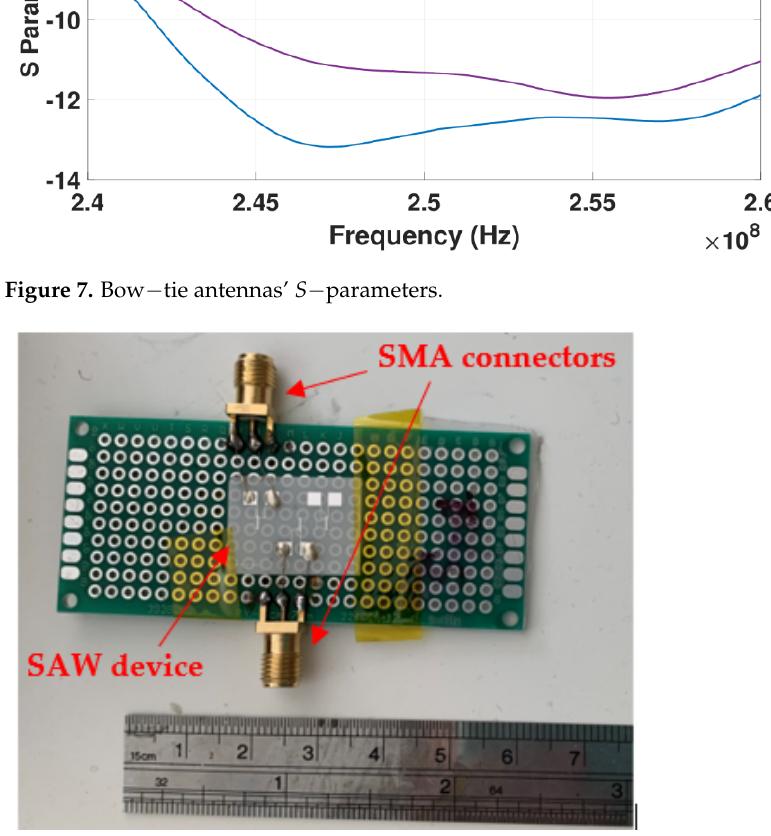
Figure 9. Variable load board.